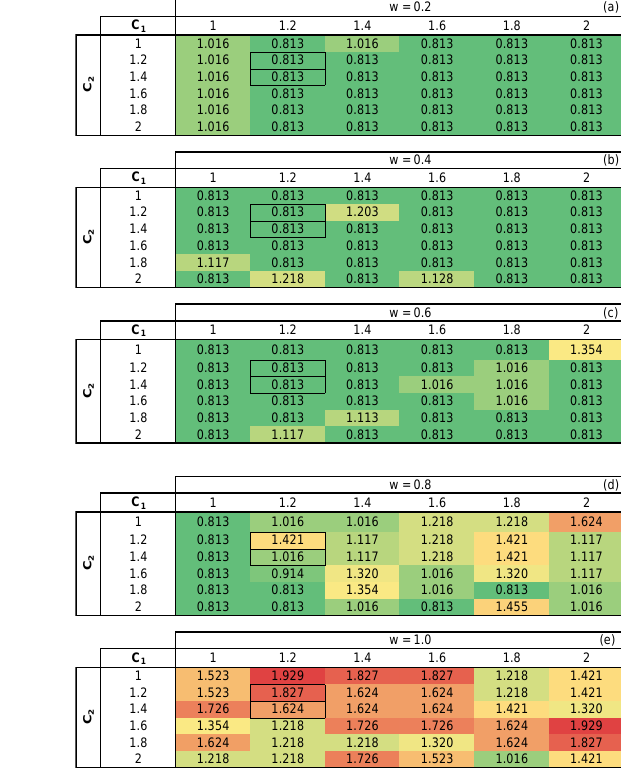
Table 5. Average convergence time in seconds for five particles.